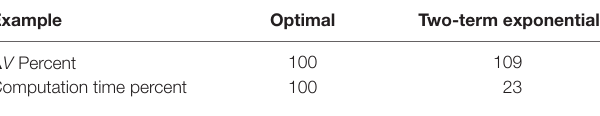
Table 2 | Δ V and computation time cost comparison between the optimal and two-term exponential trajectories.